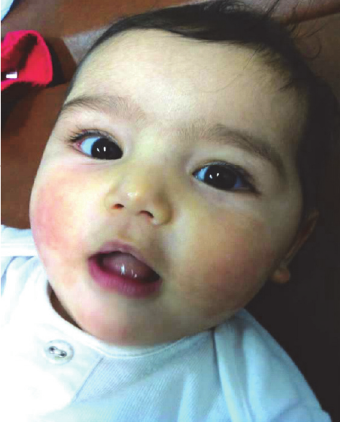
Figure 4: On follow-up day